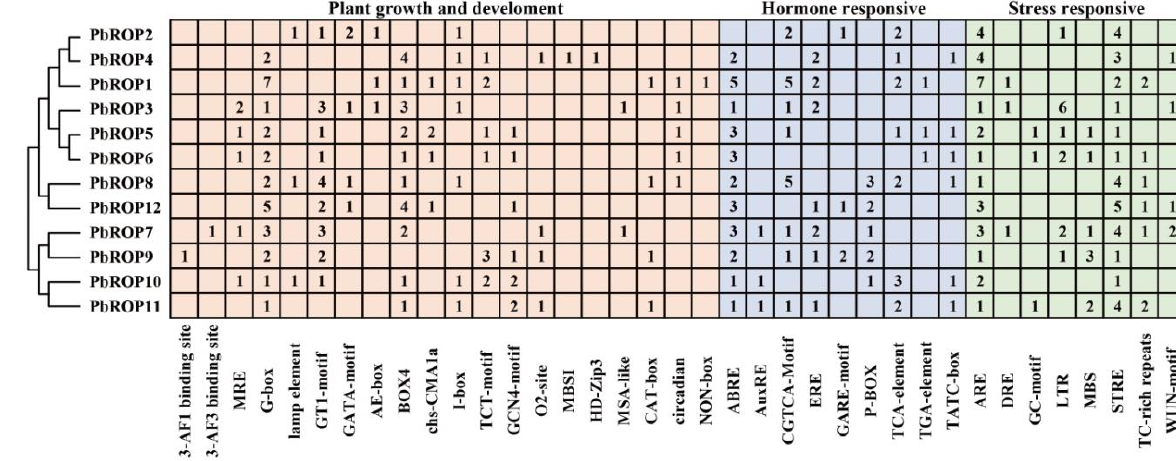
Figure 6. Analysis of the cis -acting elements in the promoter regions of PbROP genes of ‘ Duli ’ pear ( Pyrus betulifolia Bunge). The three common cis -acting elements identified were related to (1) plant growth and development (shaded in pink), (2) hormone response (shaded blue), and (3) stress response (shaded green). The number represents how many copies of cis -acting elements are present. The 2 kb sequences upstream of the transcriptional start codon ATG of all 12 PbROP genes were analyzed using the PlantCARE software. The figure was constructed by Microsoft and MEGA 6.0 software.